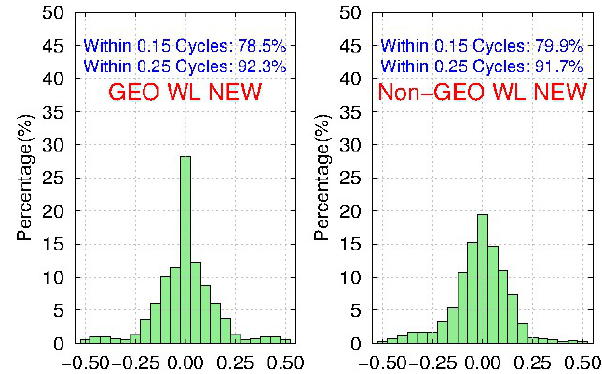
Figure 12. The distribution of BDS WL fractional parts after removal of FCBs estimated by the new strategy for 103 MGEX stations during DOY 061-090, 2018.